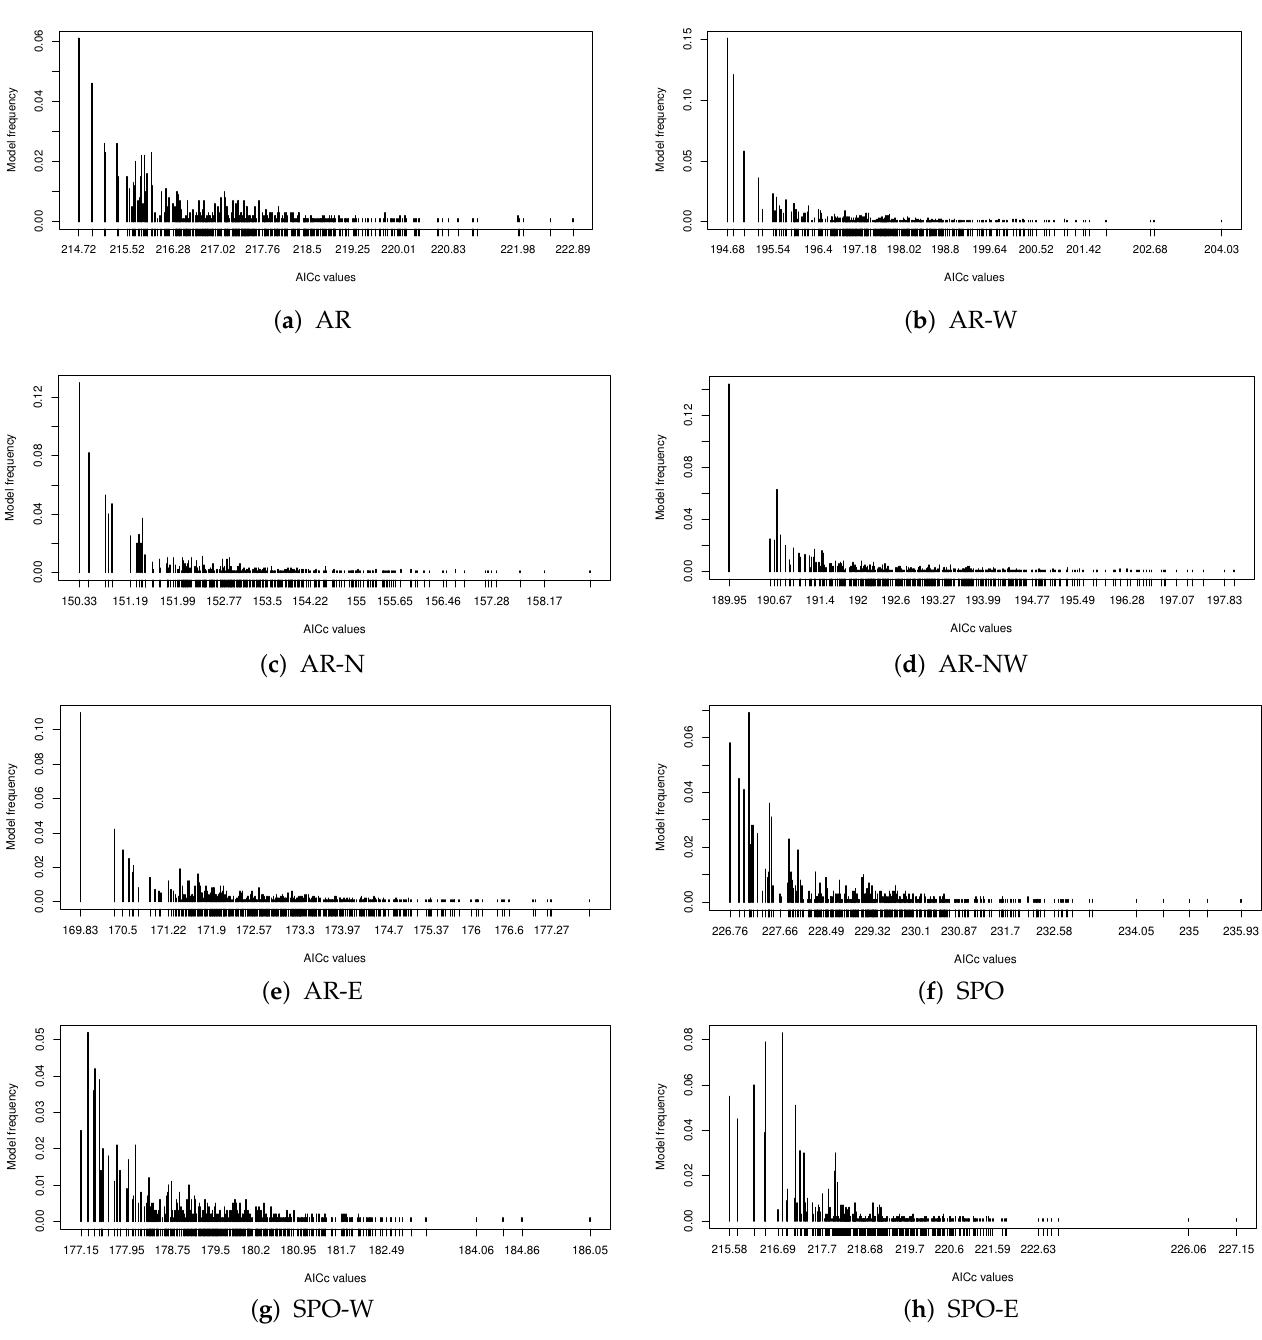
Figure 3. Sampling frequency of each model present in the generated model sequence versus its AICc value for each